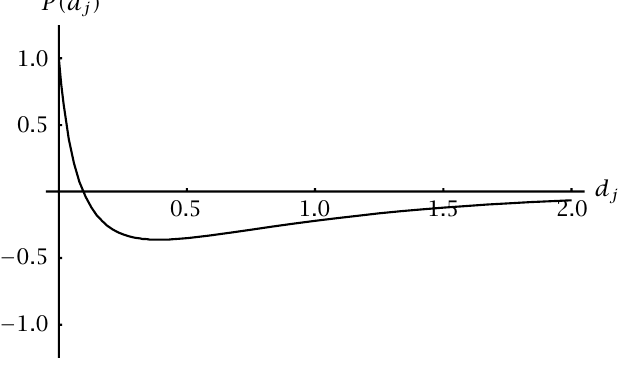
Figure 6.1 . Product ratio P(d j ) for b(t) = b cos (πt) , | b | <